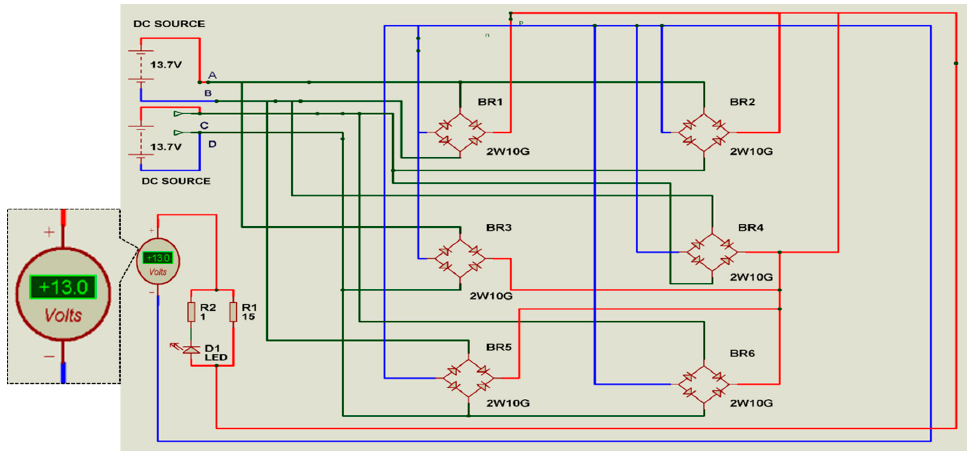
Figure 6. Simulation results regarding four contact pins: 2 positives (A, C) and two negatives (B, D).